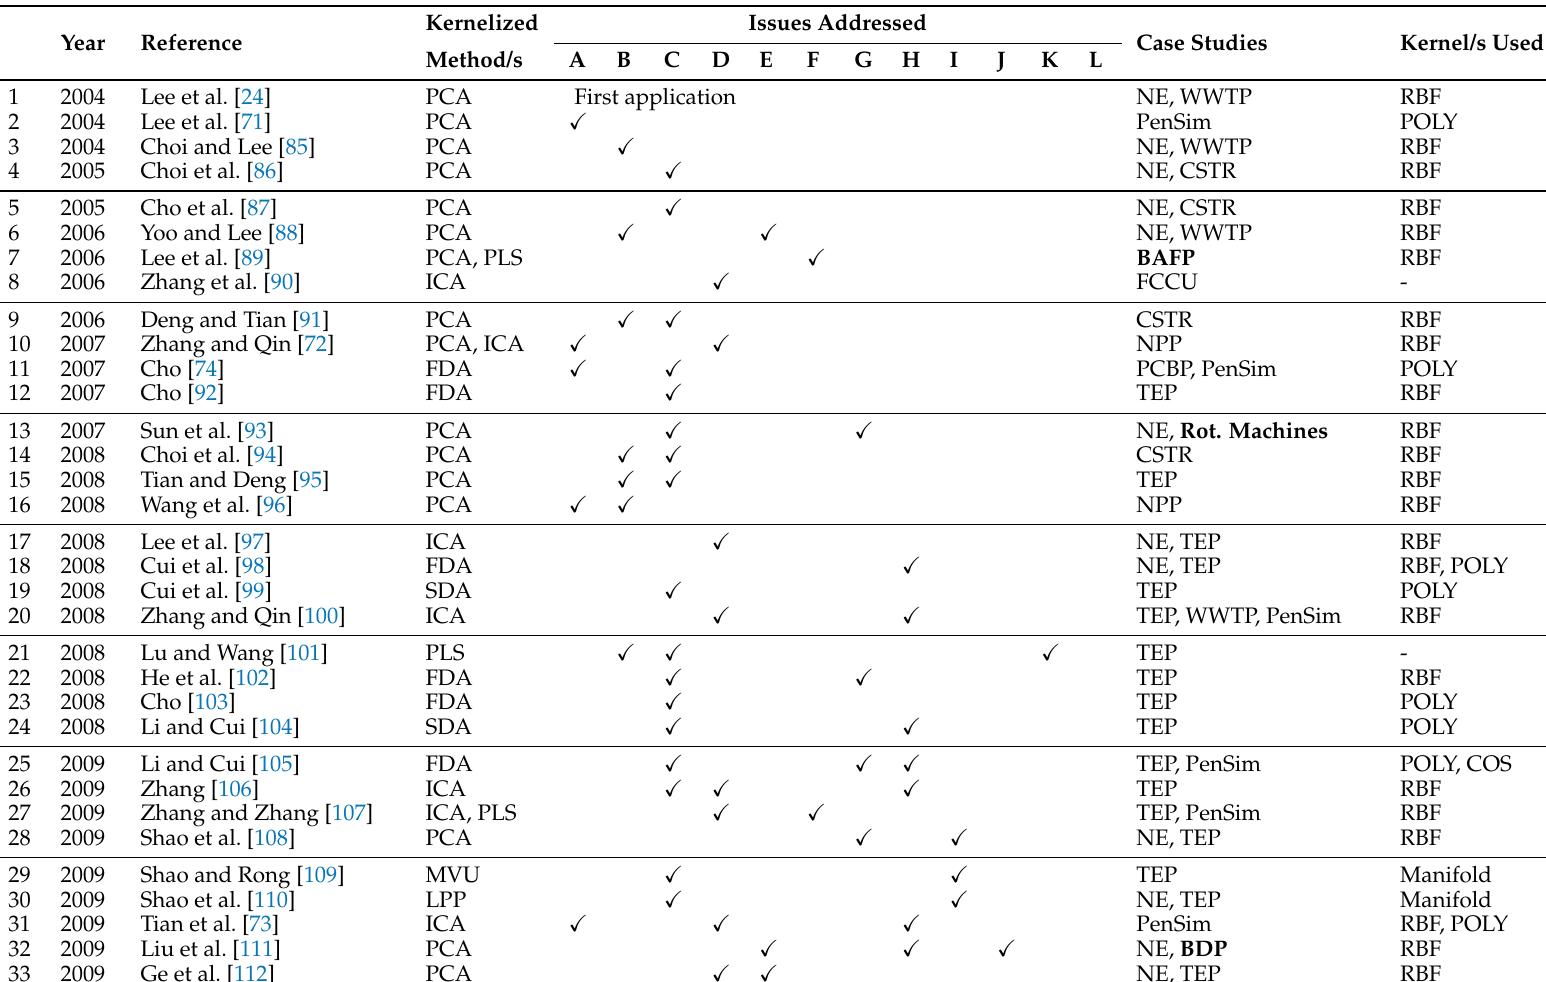
Table 3. Summary of papers: The issues they addressed and the kernel method, case studies, and kernel functions they